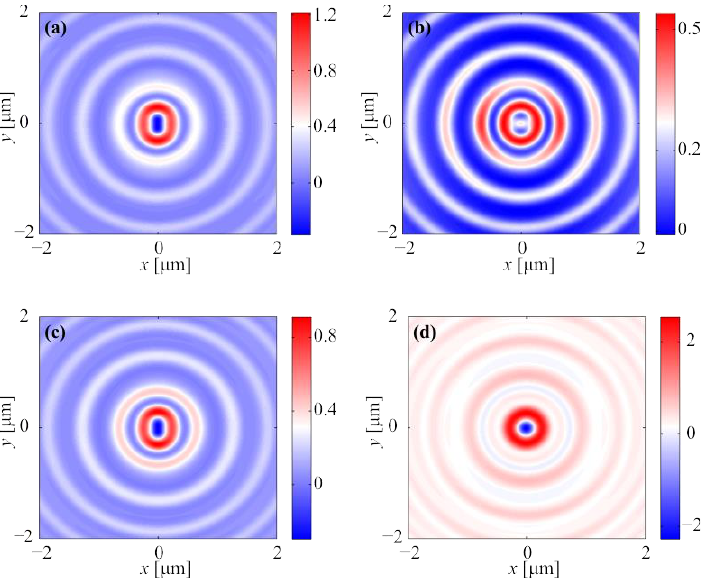
Figure 13. The averaged pattern of the longitudinal component of the Poynting vector S z of the second-order CVB in the focus of the BZP with relief from: aluminum with height of 50 nm ( a ), gold with height of 140 nm ( b ), chrome with height of 70 nm ( c ), and quartz with height of 532 nm ( d ).